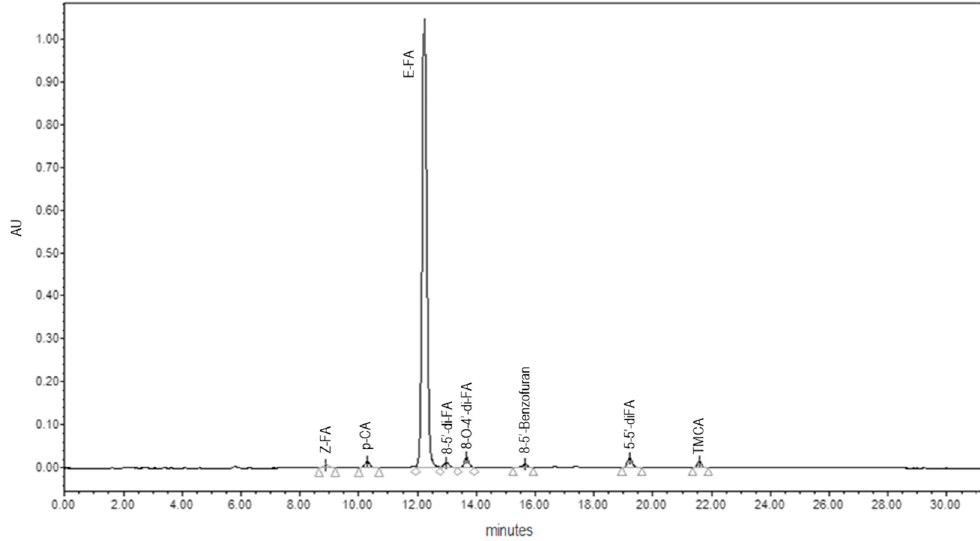
Figure 3. HPLC chromatogram of phenolic acids for ferulated arabinoxylans (AX) sample.